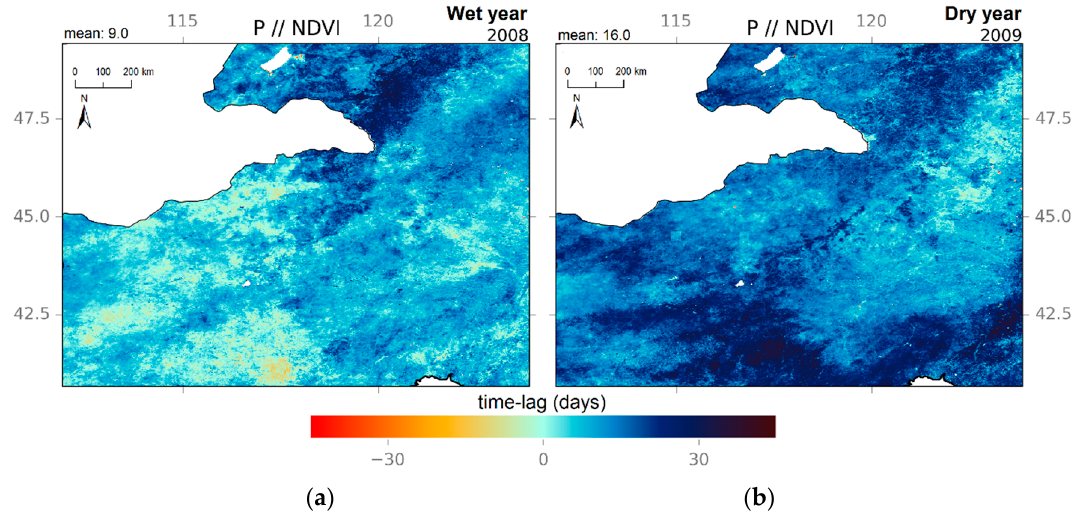
Figure 9. Time lag (days) in the wet (2008) ( a ) and dry (2009) ( b ) year of the annual component the study region in northeastern China. In the wet year with positive anomalies, the time lag was on average 9 days. In the dry year with negative anomalies, the time lag averaged 16 days. Table 1. Distribution of the time lag of the annual component in the wet year and dry year. Time Lag (Days) Wet Year (2008) (%) Time Lag